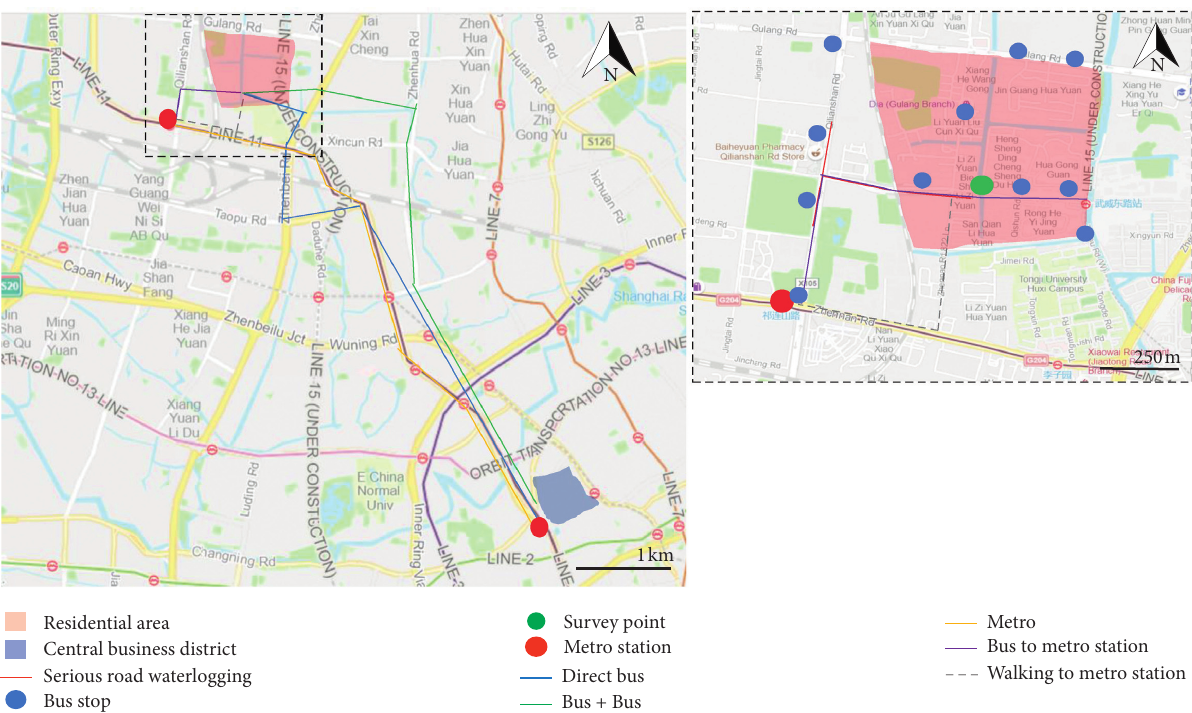
Figure 1: Shanghai, the study context.